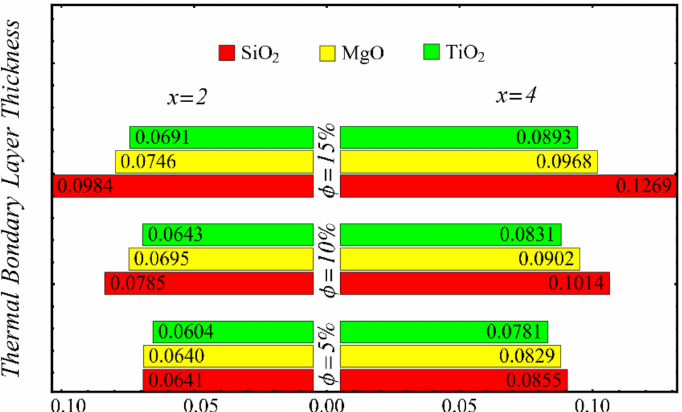
Figure 20. Temperature boundary-layer thickness at different nanoparticle concentrations.